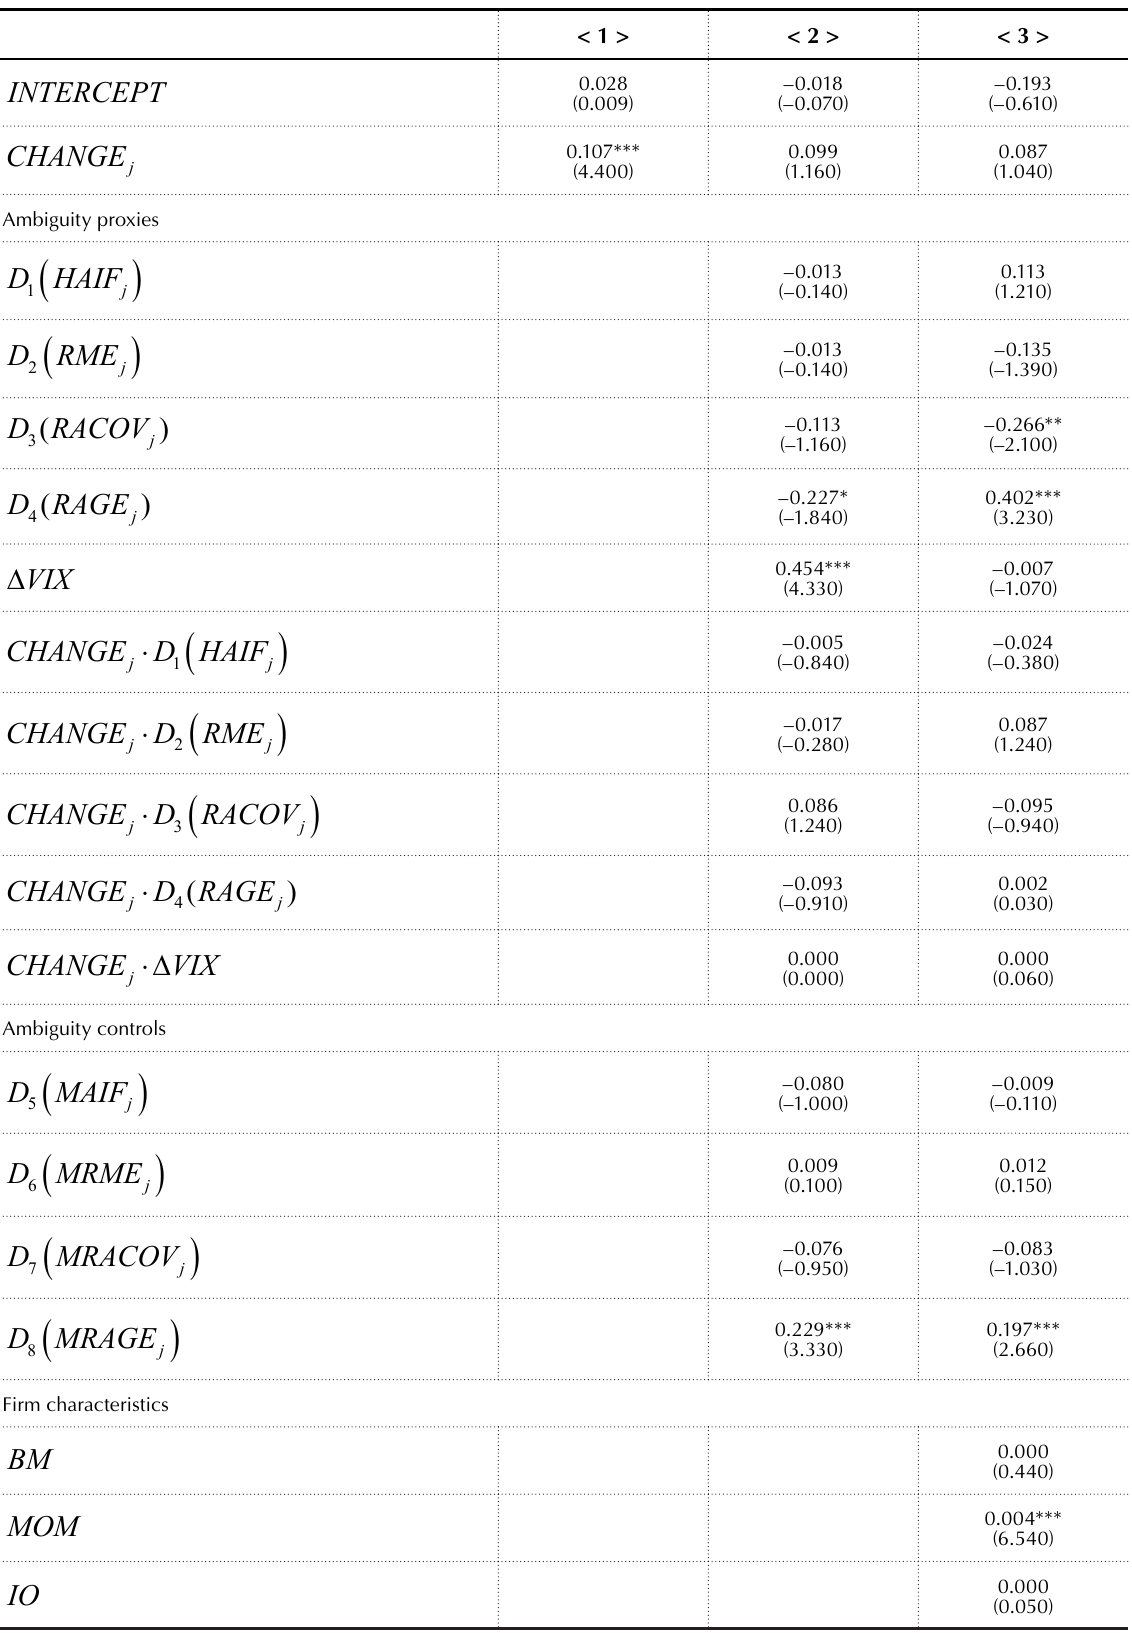
Table 3. Ambiguity and two-day buy-and-hold abnormal